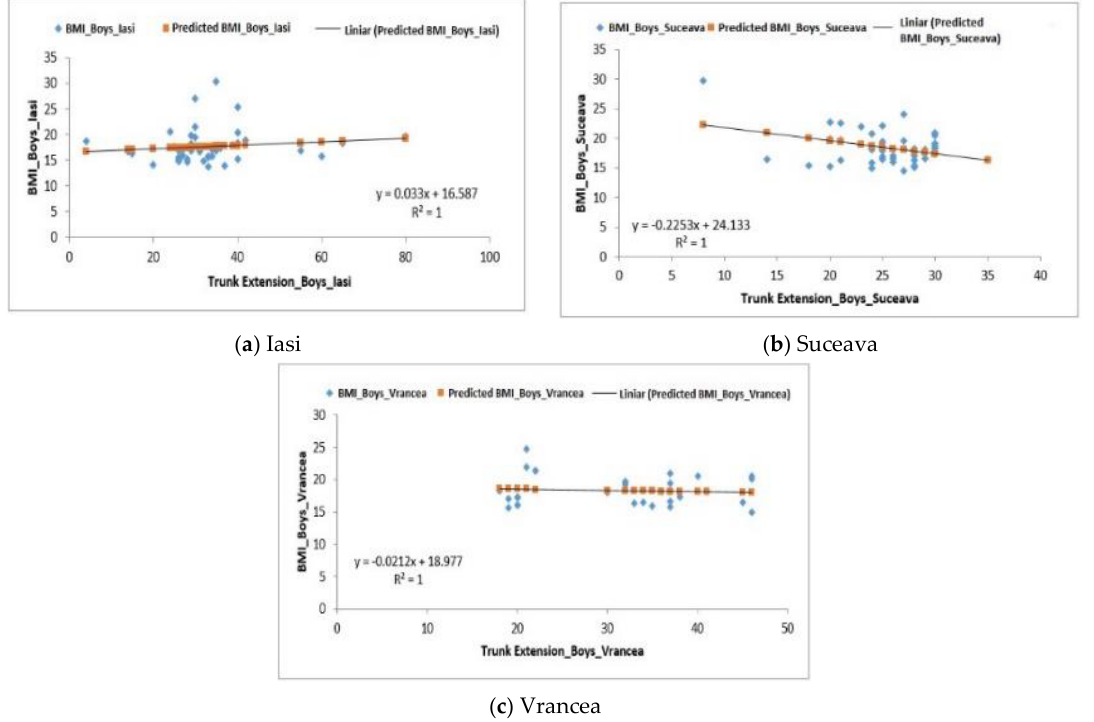
Figure 7. Relationship between the BMI and the upper body extension test for the boys in the three regions.